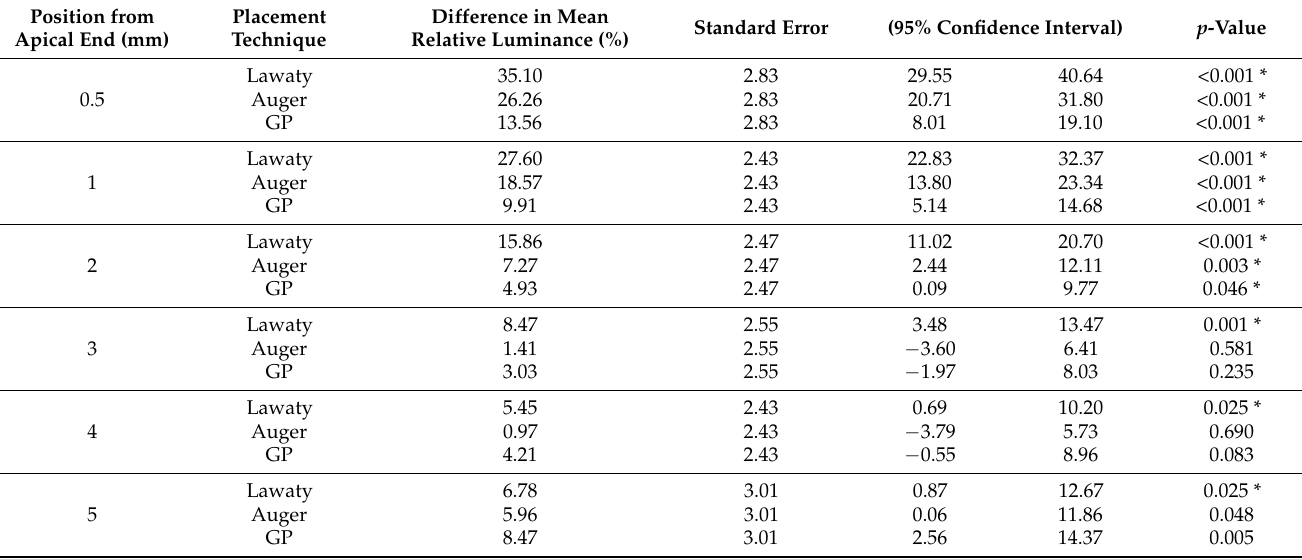
Figure 3. Comparison of the estimated mean values for relative luminance for each group at various depths from the apical end. Estimated differences in mean relative luminance compared to the plugger group generally decreased as the distance from the apex increased. Table 2. Results of the estimated differences in mean relative luminance (95% confidence intervals) with plugger group set as the reference group.